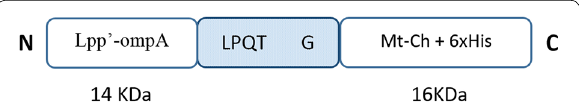
Fig. 1 Schematic representation of the chimeric construct LO-Mt-Ch. Carrier lipoprotein Lpp ′ -ompA is fused to the chimeric protein using srtA recognition site, LPQTG (not drawn to scale). Mt stands for metallothionein from Synechococcus elongatus and ChBD represents chitin binding domain of chitinase (ChiS) from B. pumilus